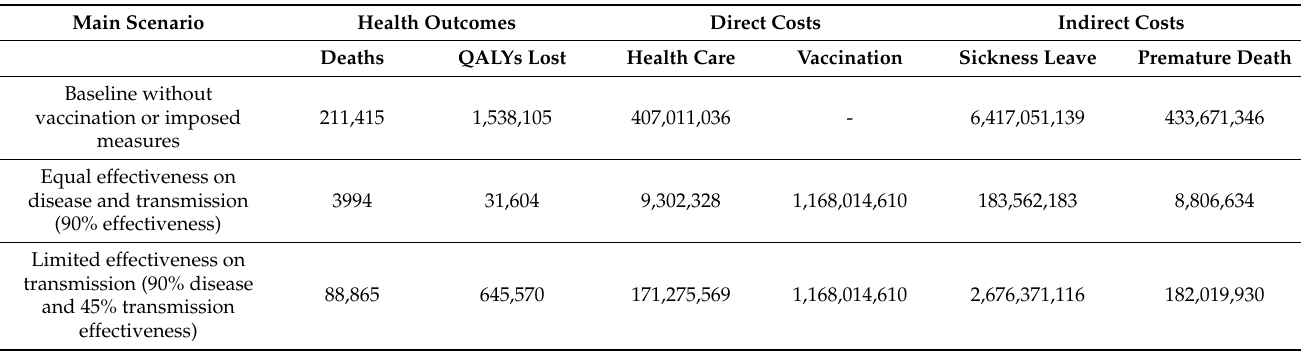
Table 2. Overview of scenario results from the healthcare and societal perspectives (all costs are in USD, and a discount rate of 3% is used for the QALYs).